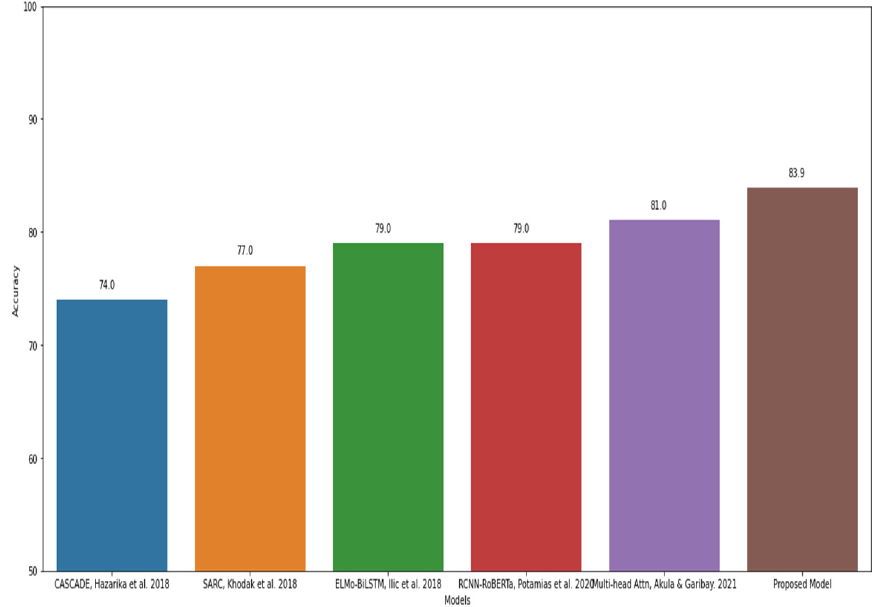
Figure 11. Accuracy comparison of previous research [22,23,27,55,56] over the SARC dataset.